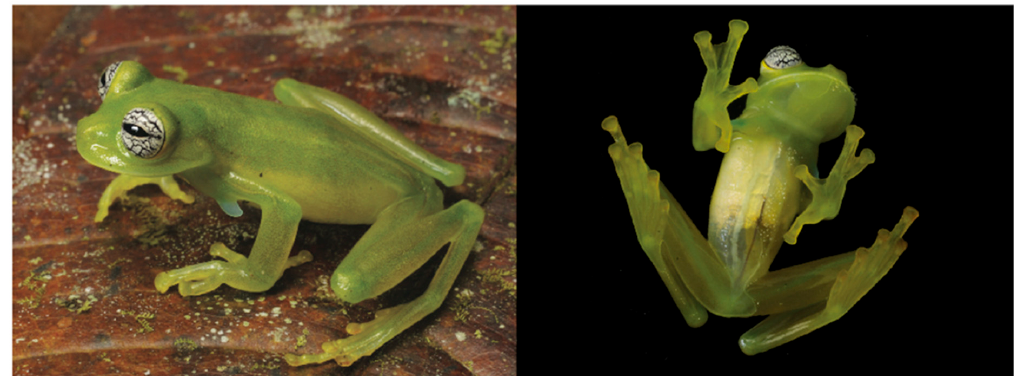
Figure 89. Espadarana callistomma in life from Durango, Esmeraldas province, Ecuador. Adult male, QCAZ 32055. Photo by Martín Bustamante.